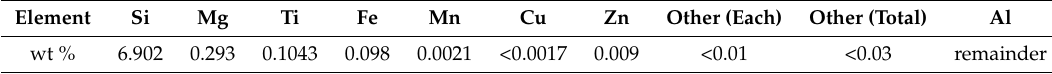
Figure 2. Die structure and cooling channel locations. Note: (1) the cooling channel labels are not sequential and have been reported following the conventions used by the industrial partner; and (2) not all channels were used (T5 and B5 were unused). Table 1. Chemical composition of A356 aluminum